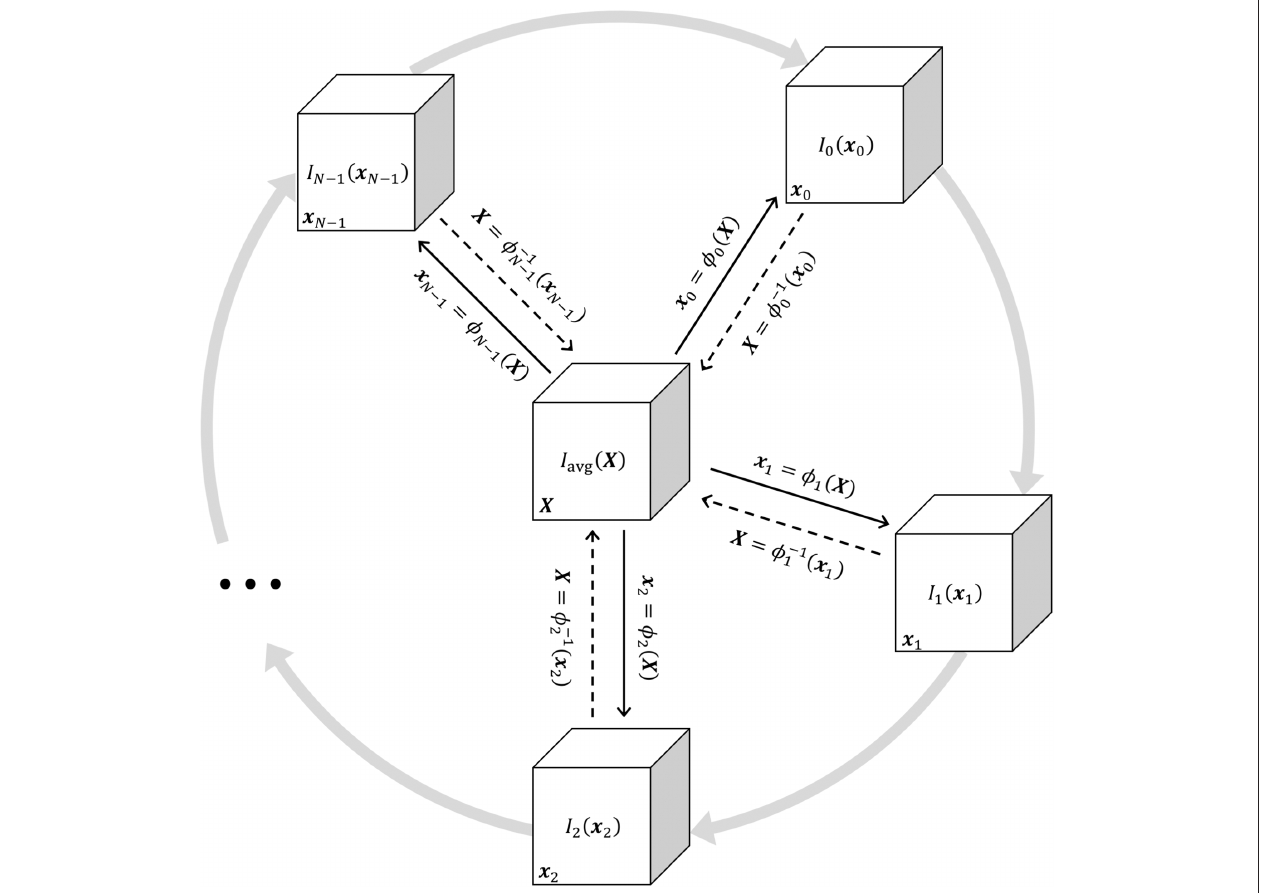
FIGURE 1 | Schematic illustrating the jointly estimated 3D transformations φ n ( X ) the target average image I avg ( X ) . Solid black arrows indicate the transformation from the target reference frame X to the general reference frame x n . Dashed black arrows indicate the inverse transformation. Gray arrows represent the periodic sequence of N ventilatory phases indexed from 0 to N deformed to achieve structural alignment with any other I m ( x m ) by applying a sequence of two transformations x n